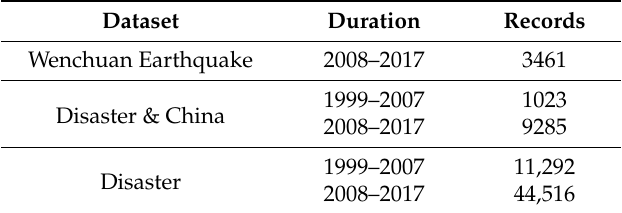
Table 1 . Summary of the topics searched for in our database. Table 1. Summary of the topics searched for in our